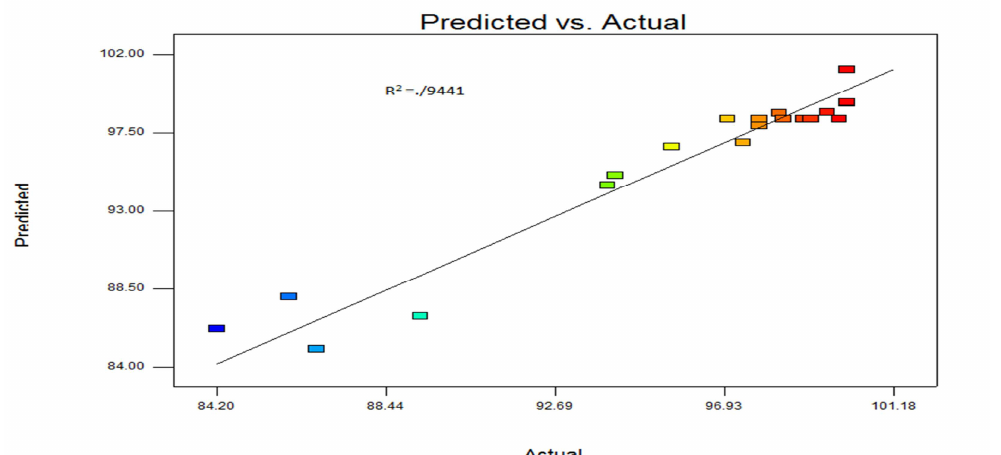
Figure 5. The actual and predicted plot of degradation of acid black 1 (R2